Question: Give a one-sentence summary of this figure.
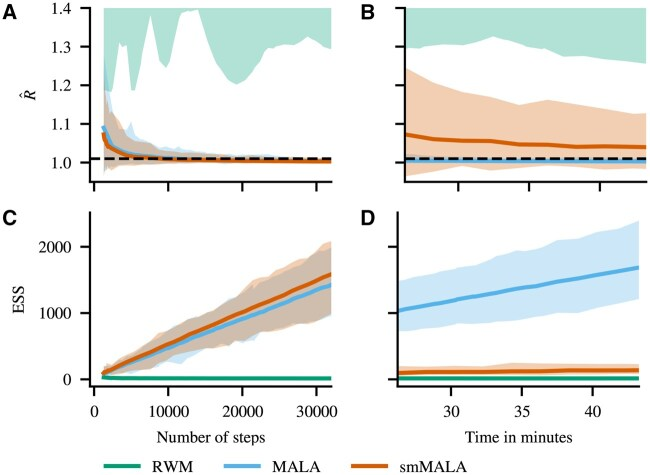
Answer: Mean, minimum, and maximum R ^ and effective sample size (ESS) of all parameters from MCMC samplers applied to an MHN trained on the LUAD dataset with the symL2 penalty [ Equation (4)] . The metrics for RWM, MALA and smMALA are plotted against number of steps and time. Diagnostics were evaluated after discarding the first 20% of the steps as burn-in.